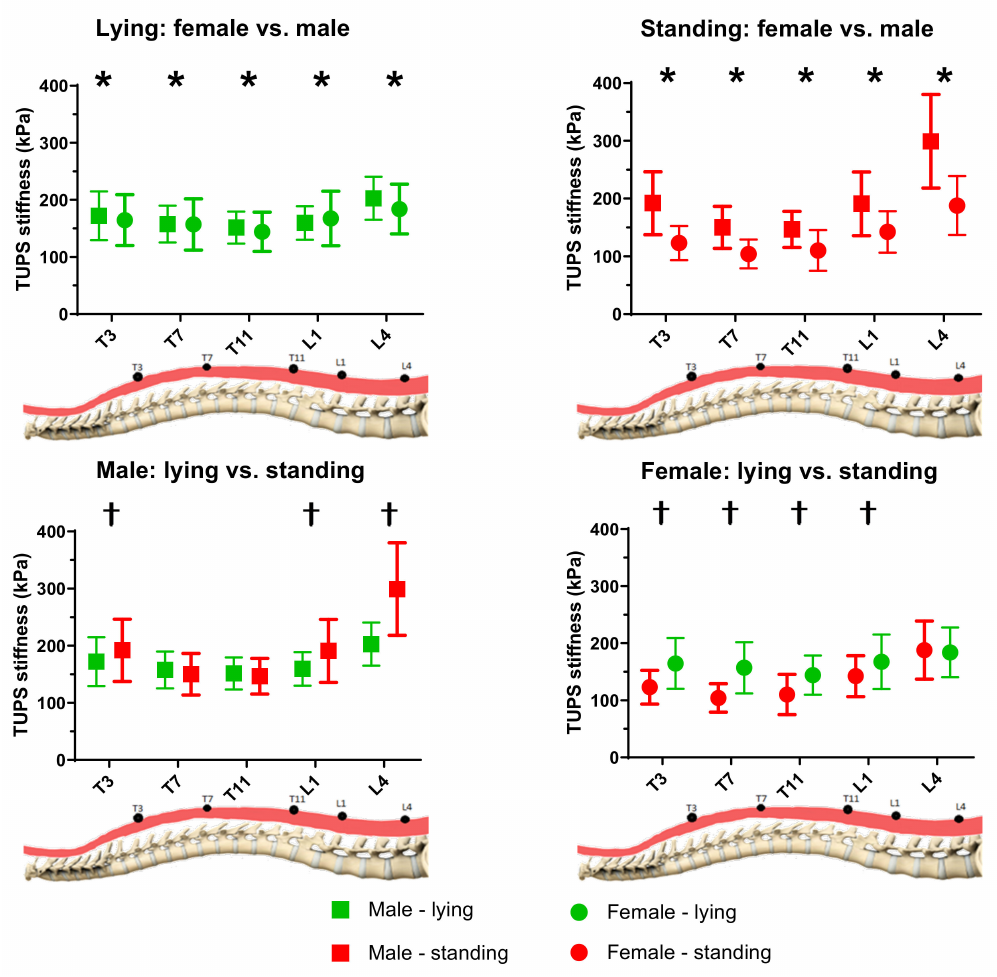
Figure 2. TUPS sti ff ness at di ff erent levels of two genders in lying and standing postures ( n = 64). * Significantly di ff erence in gender; † Significant di ff erence in